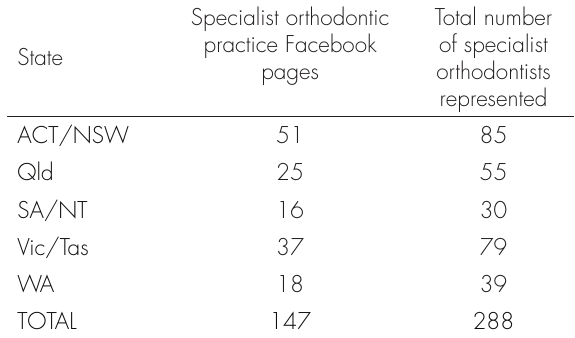
Table I. Distribution by region of specialist orthodontic practice Facebook pages and total number of specialist orthodontists